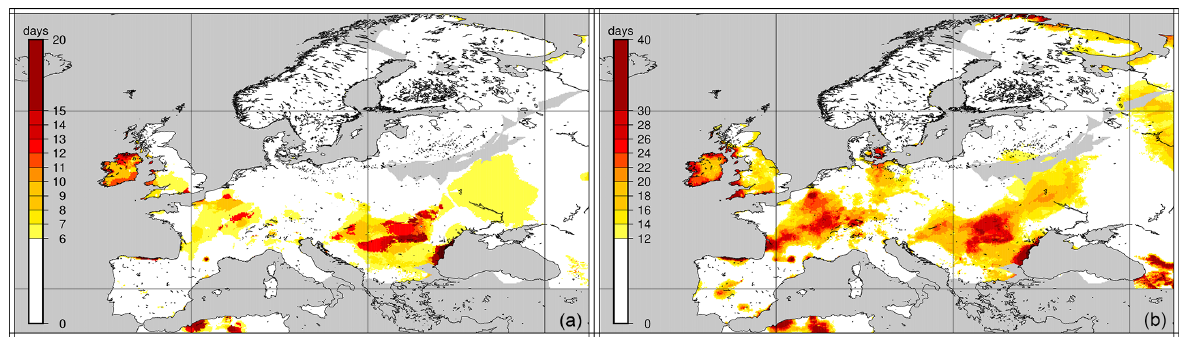
Figure 9. Maps showing (a) the warm spell duration index for summer 1921, a heatwave index relating to the locally defined threshold of the 90th percentile in daily maximum temperature and with a minimum length of 6 consecutive days above this threshold, and (b) the number of days above this 90th percentile threshold, regardless if they are clustered in time or not. Based on the E-OBS dataset.